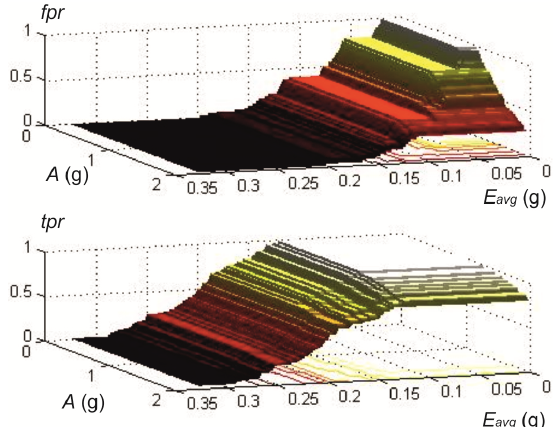
Figure 4. fpr (top) and tpr (bottom) values as a function of threshold values for the personalized isotropic